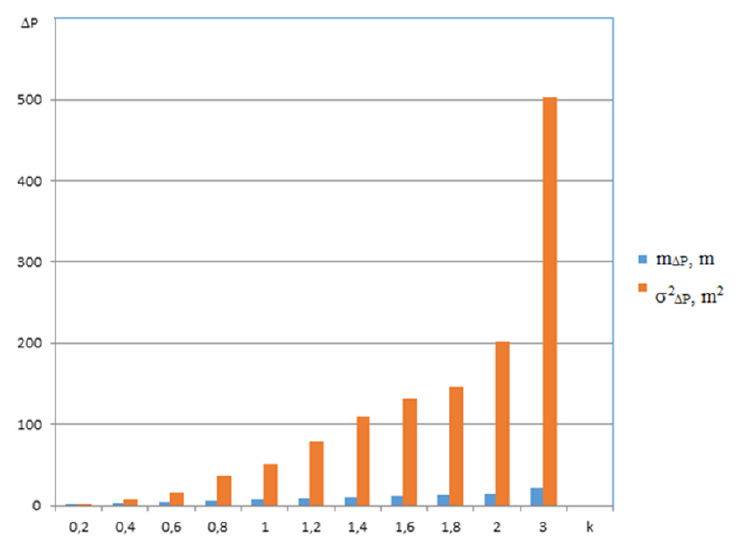
Figure 7. Accuracy of ACS positioning for straight flight.